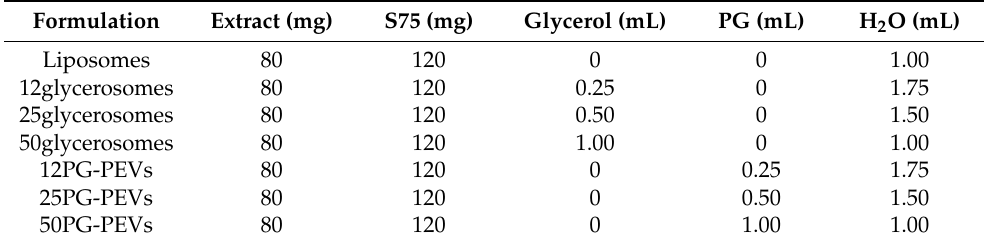
Table 1. Composition (mg/mL) of liposomes, glycerosomes and propylene glycol-penetration enhancers containing vesicles (PG-PEVs). Formulation Extract (mg) S75 (mg) Glycerol (mL) PG (mL) H 2 O (mL) Liposomes 80 120 0 0 1.00 12glycerosomes 80 120 0.25 1.75 25glycerosomes 50glycerosomes 12PG-PEVs 25PG-PEVs 80 1.50 50PG-PEVs 80 120 0 1.00 1.00 S75: Lipoid S75. PG: propylene